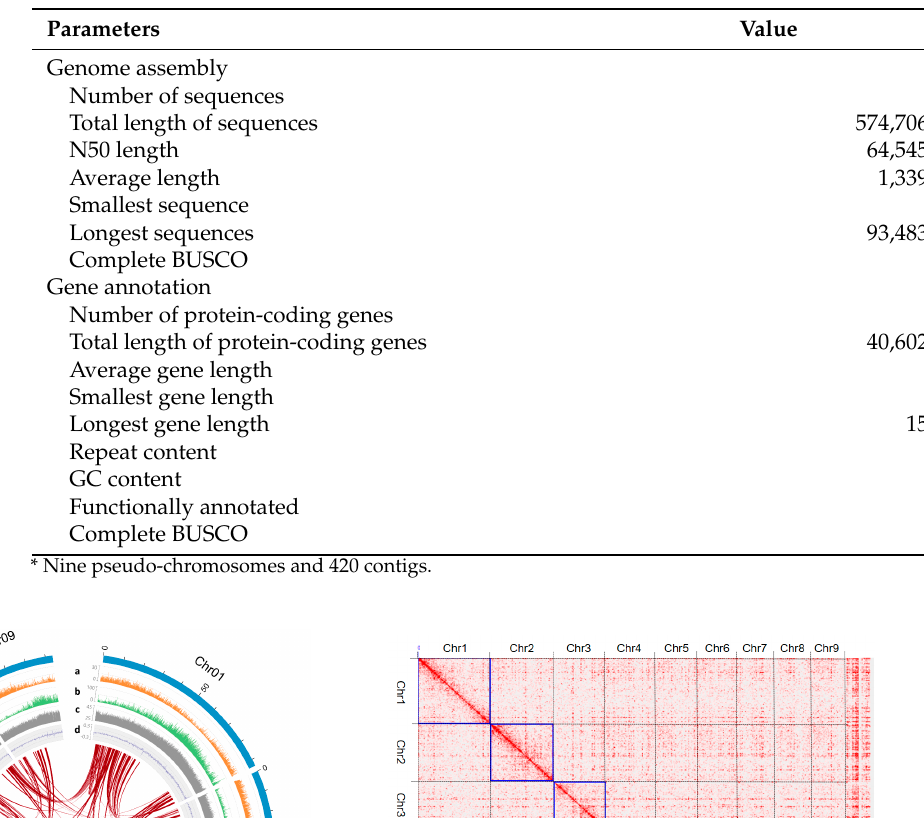
Table 1. Genome assembly and gene annotation of P. grandiflorum .